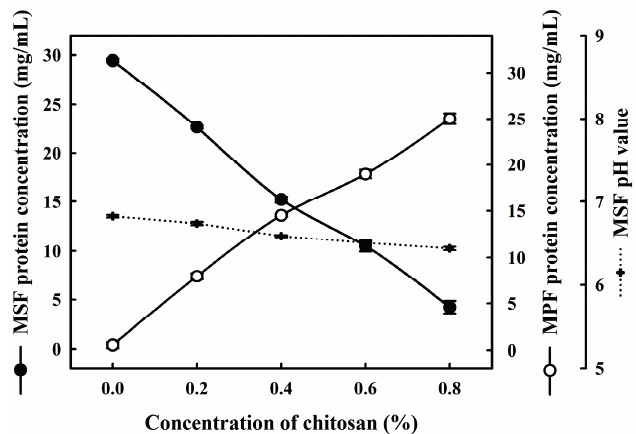
Figure 1. Changes in the total protein content and pH of milk with different concentrations of chitosan. ● : milk supernatant fraction, MSF; ○ : milk pellet fraction,